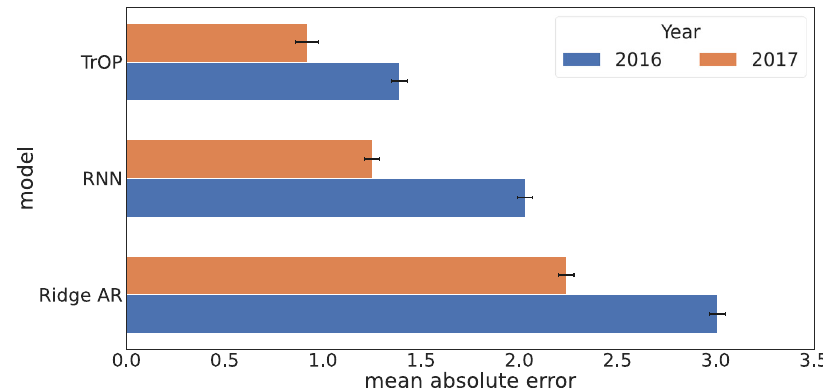
Fig. 3 Model error by test year. Mean absolute error (MAE) and 95% con fi dence intervals across our 2 test years for each statistical model. T R OP showed lower error in both years compared to other approaches. The overall gain fromT R OP appeared to be in having a more robust prediction of 2016, with a reduction of 0.6 MAE when compared to RNN. However, all models followed the same trend of 2016 being a bit harder to predict than